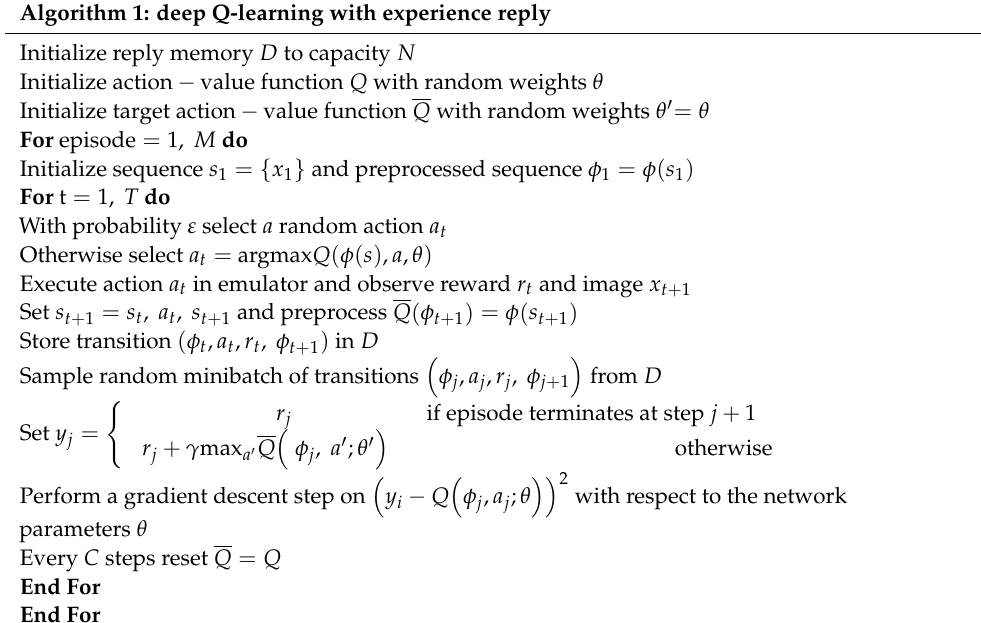
Algorithm 1: deep Q-learning with experience